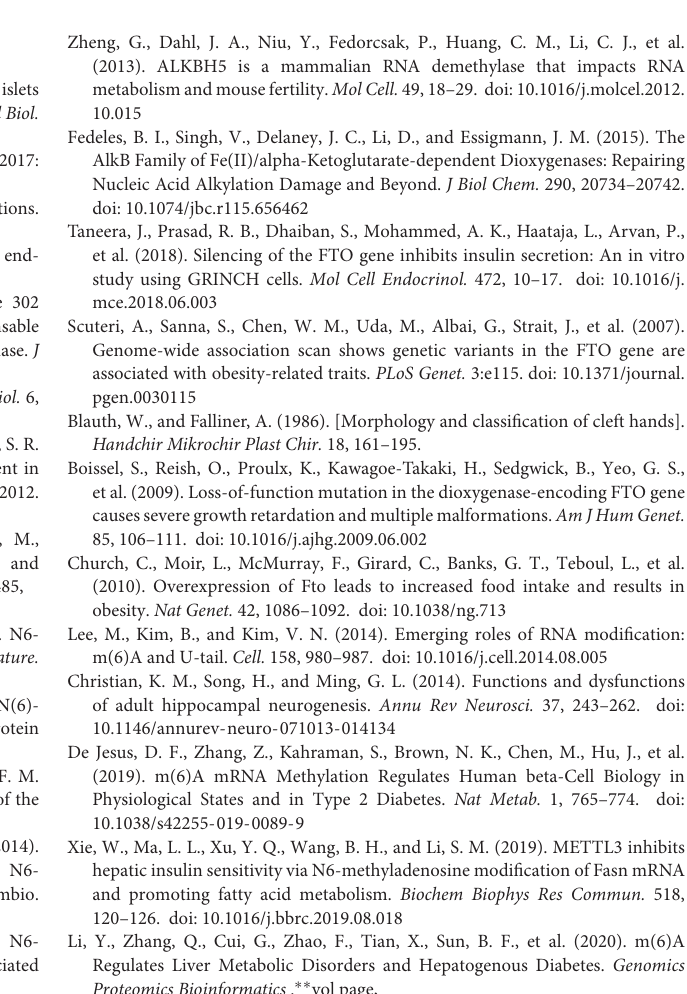
Supplementary Figure 1 | Co-m 6 AR co-expression network. Functional protein-protein interaction network of Co-m 6 AR genes in control versus T2DM islet β -cells was shown, the key genes were marked with green asterisk. Supplementary Figure 2 | Co-expression network of Co-m 6 AR with m 6 A methylation in β -cells. Functional protein-protein interaction network of differently expressed genes with METTL3 , EIF3G , YTHDF1 , YTHDF2, and ALKBH5 was shown, and these five RNA m 6 A methylation regulators were marked with blue